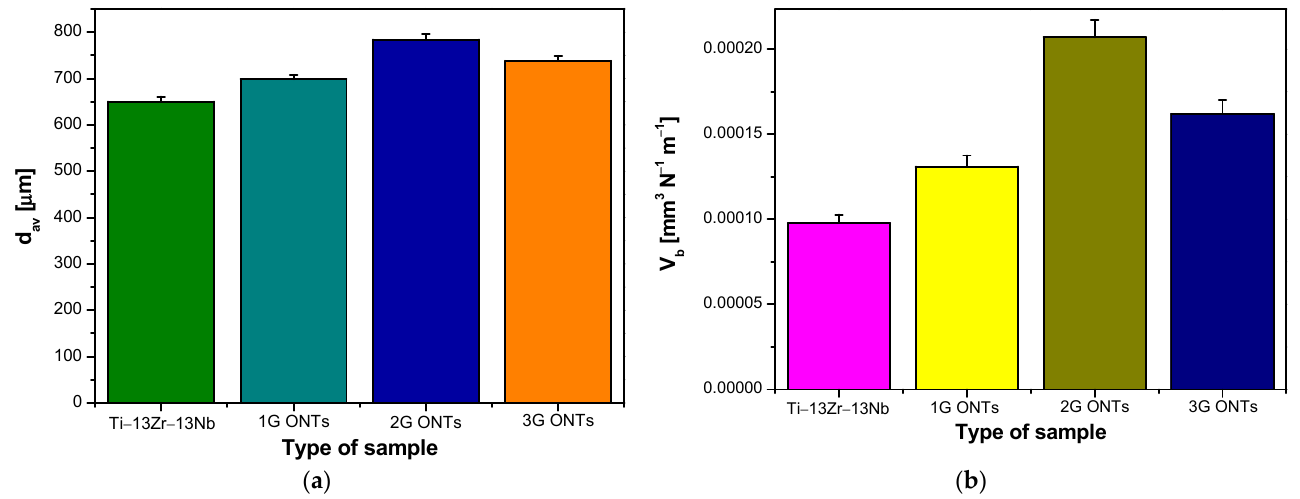
Figure 5. Parameters obtained after the biotribological wear test in the ball-on-flat system for the Ti–13Zr–13Nb alloy before and after anodizing: ( a ) ZrO 2 ball wear scar (d av ); ( b ) ZrO 2 ball-specific wear (V b ).